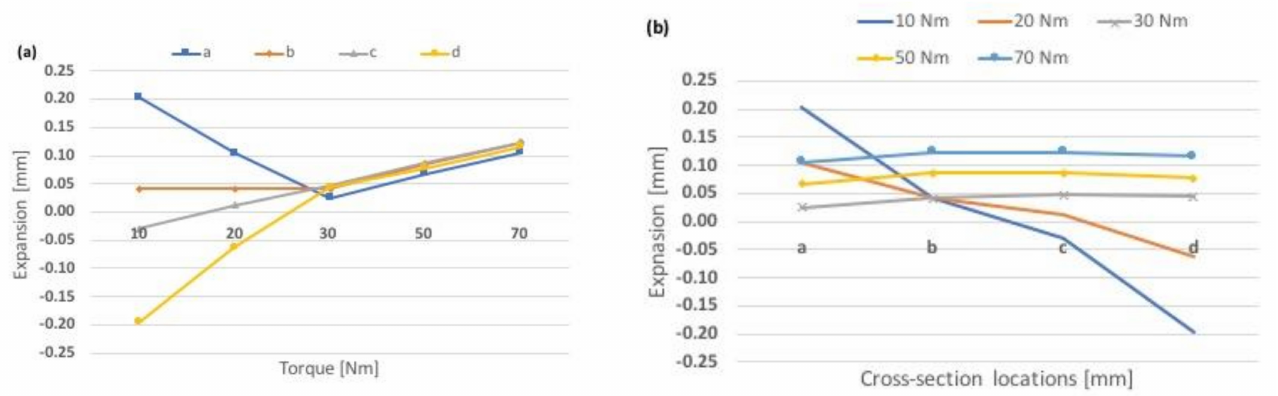
Figure 11. Test 1b—Ring deformations of lubricated single bearing ring on double sleeve: ( a ) expansion as a function of torque and ( b ) expansion at different cross-section